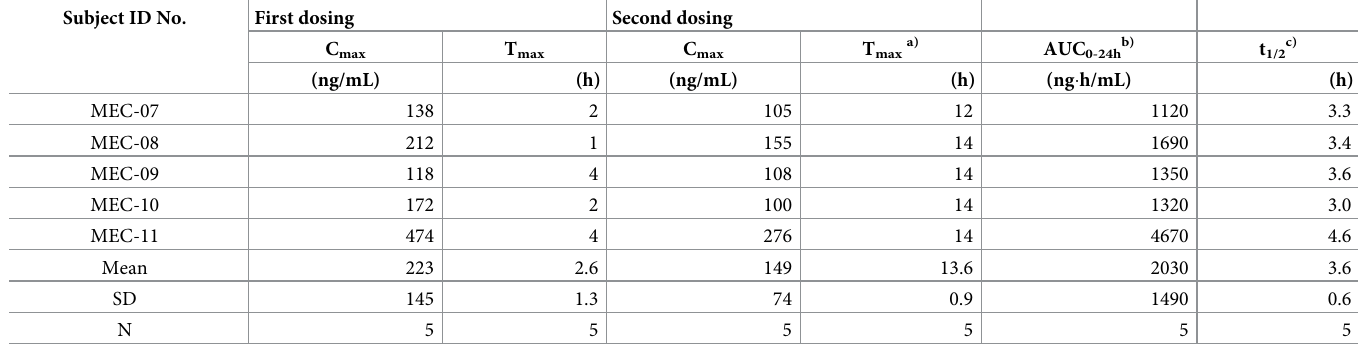
Table 3. Pharmacokinetic parameters of meclizine in achondroplasia children after twice a day oral administration of meclizine hydrochloride 25 mg